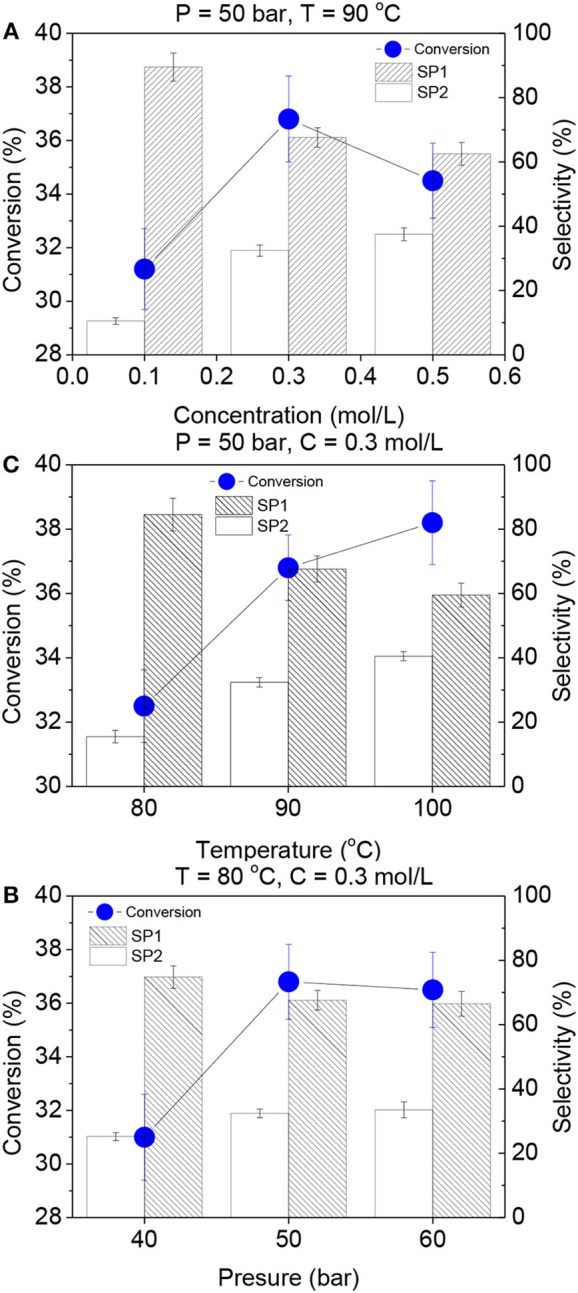
(A) Catalytic performance of g-C3N4/Pt at different concentrations of levulinic acid, (B) catalytic performance of g-C3N4/Pt at different temperatures, (C) catalytic performance of g-C3N4/Pt at different pressures. SP1: selectivity to 1-ethyl-5-methylpyrrolidin-2-one, SP2: selectivity to 1-ethyl-2-(ethylideneamino)-5-methylpyrrolidin-2-ol.